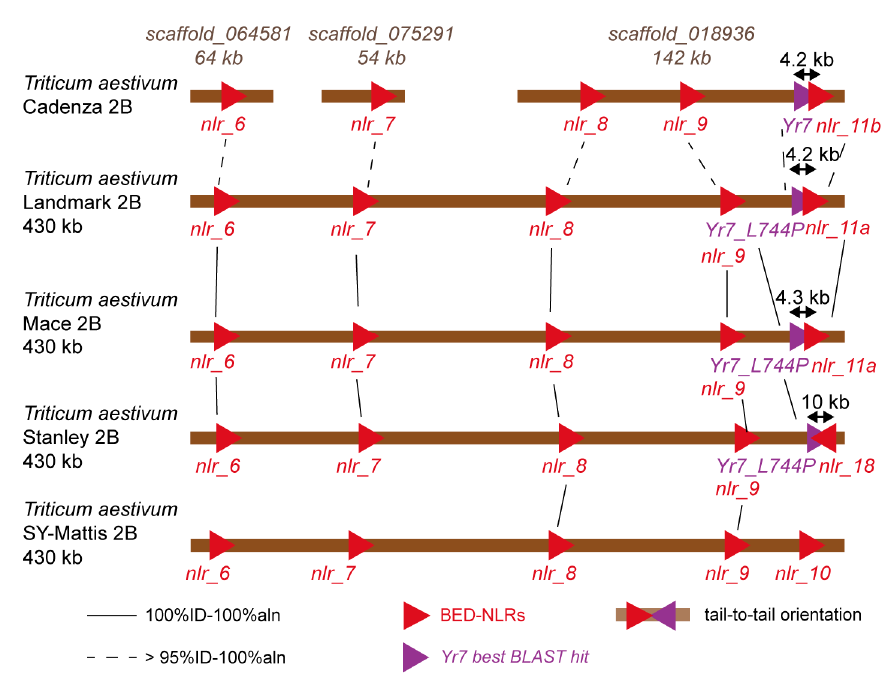
Figure 2. Close-up on the BED-NLR-rich region in Landmark, Mace, Stanley and SY-Mattis where Yr7-L744P is located. Colours and shapes shown in this figure correspond to those used in Figure 2. We added the scaffolds of the Cadenza assembly that contained hits to the Landmark BED-NLRs, including the scaffold which contains Yr7 . The orientation of the triangles reflects the orientation of the loci. We identified a BED-NLR locus in tail-to-tail orientation located 10 kb from Stanley- Yr7-L744P . In Cadenza, Landmark and Mace, we identified nlr_11a/b that was located ~ 4.5 kb and in tail to head orientation with Yr7 / Yr7-L744P .